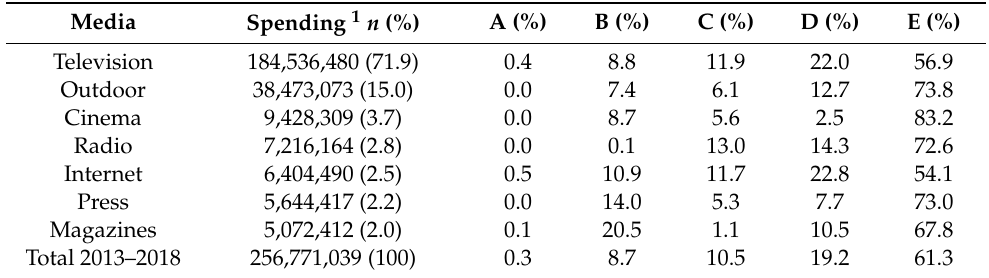
Table 3. Nutri-score classification of the advertising spending by the 10 top companies in soft drinks and sugar-sweetened beverages in Spain by